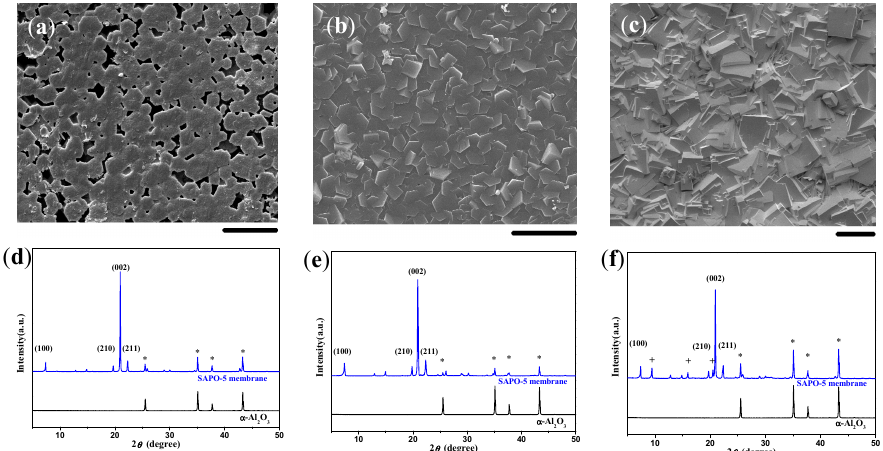
Figure 3. SEM images and the corresponding XRD patterns of SAPO-5 membranes induced by a layer of low molecular weight (LMW) chitosan using AIP as the Al source and the H 2 O/Al 2 O 3 ratio of 200 ( a , d ), 150 ( b , e ), and 100 ( c , f ). Scale bars correspond to 20 µ m in SEM images. The asterisks and plus signs mark the peaks from the α -Al 2 O 3 substrate and SAPO-34,